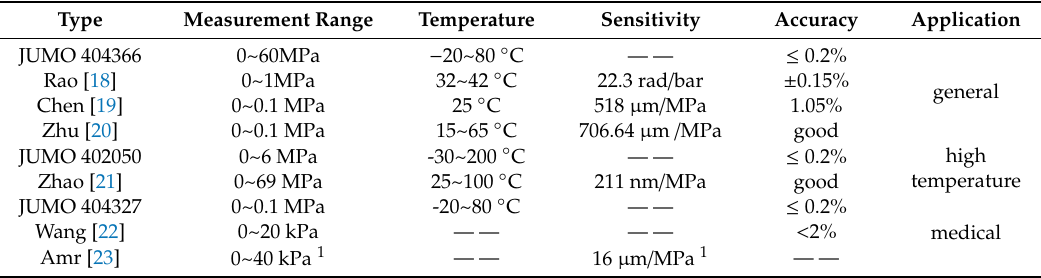
Table 1. Performance of CD-based static pressure sensors and commercial electronic pressure sensors.